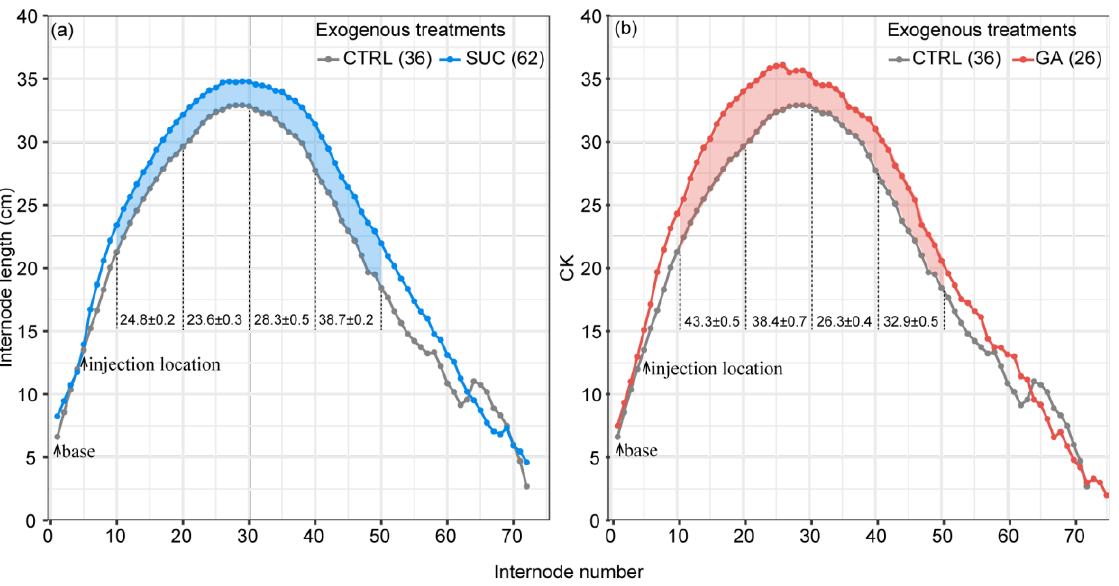
Figure 3. The internode lengths at different internodes under Suc ( a ) and GA ( b ) treatments compared with the CTRL. The points indicate the mean value of the internode length. The colored shapes indicate a significant difference in the length of every ten internodes between the Suc or GA treatment and the CTRL. The mean values and standard error of 10 internodes with a significant difference are shown between the lines. The numbers in brackets represent the sample sizes.